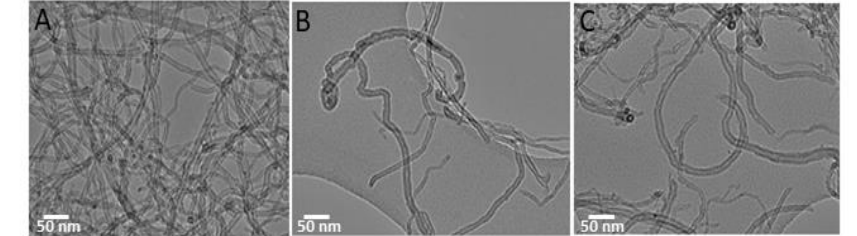
Figure 3. TEM images of MWCNT-Ox ( A ), MWCNT- EDA ( B ) and MWCNT-EPA ( C ).